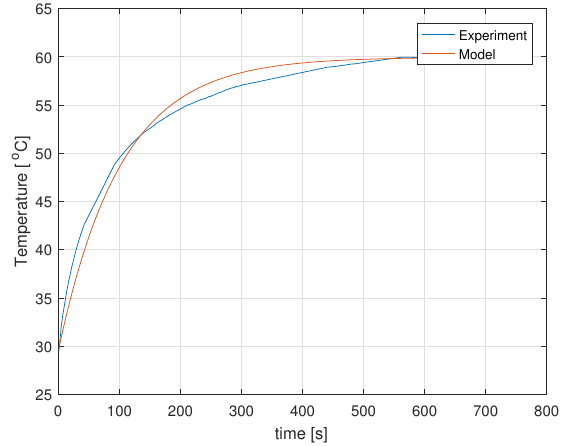
Figure 12. The step responses of the IO model and real plant for area